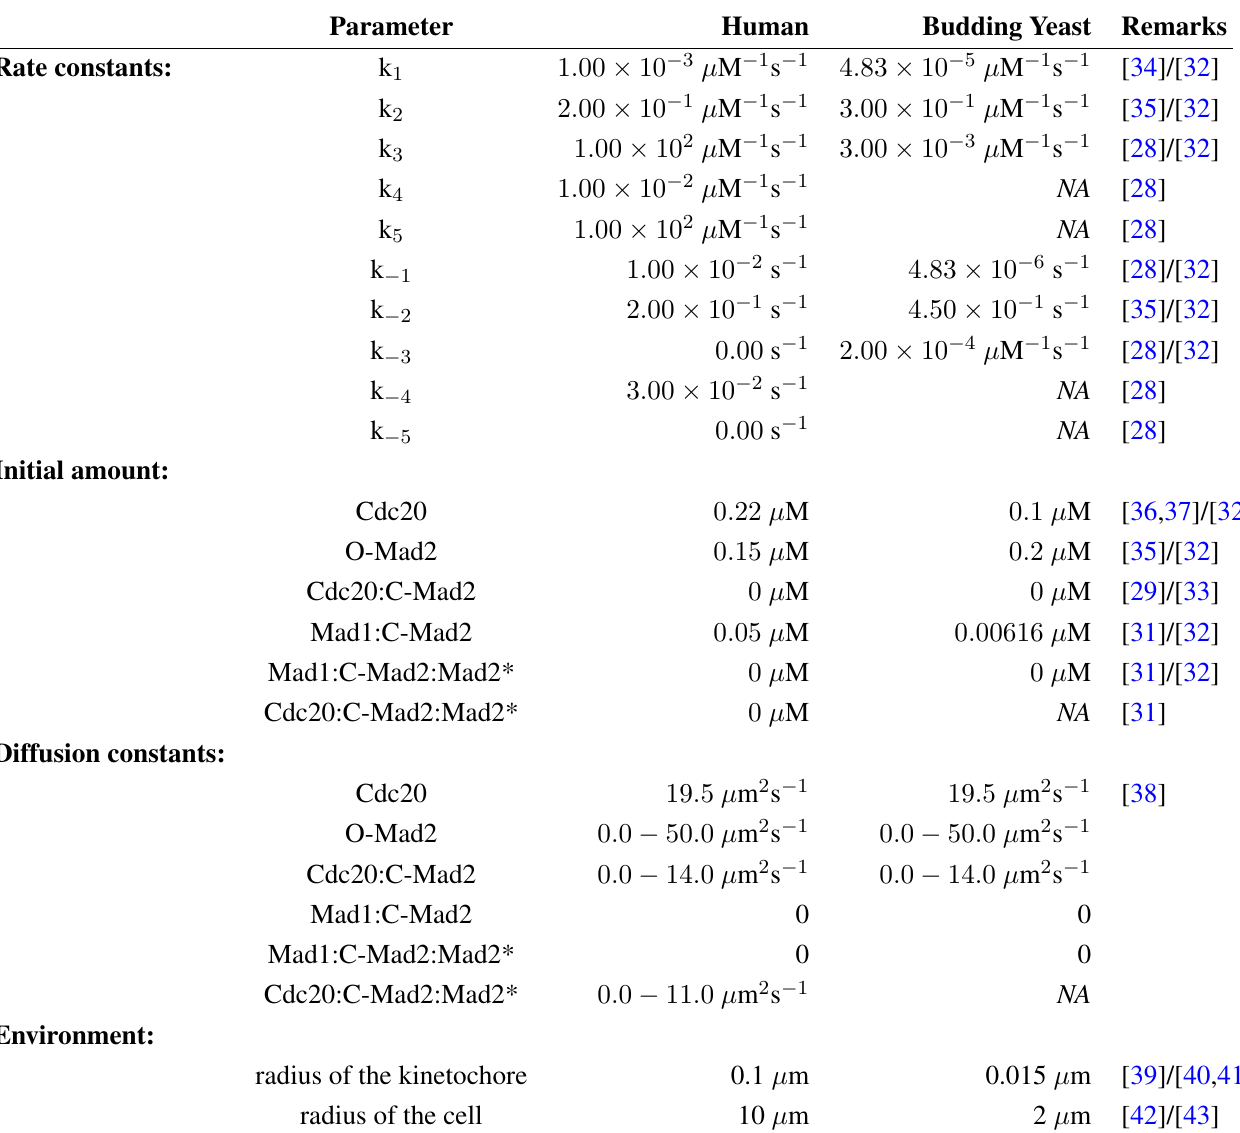
Table 1. Parameters for the mitotic spindle assembly model. Parameter Human Budding Yeast